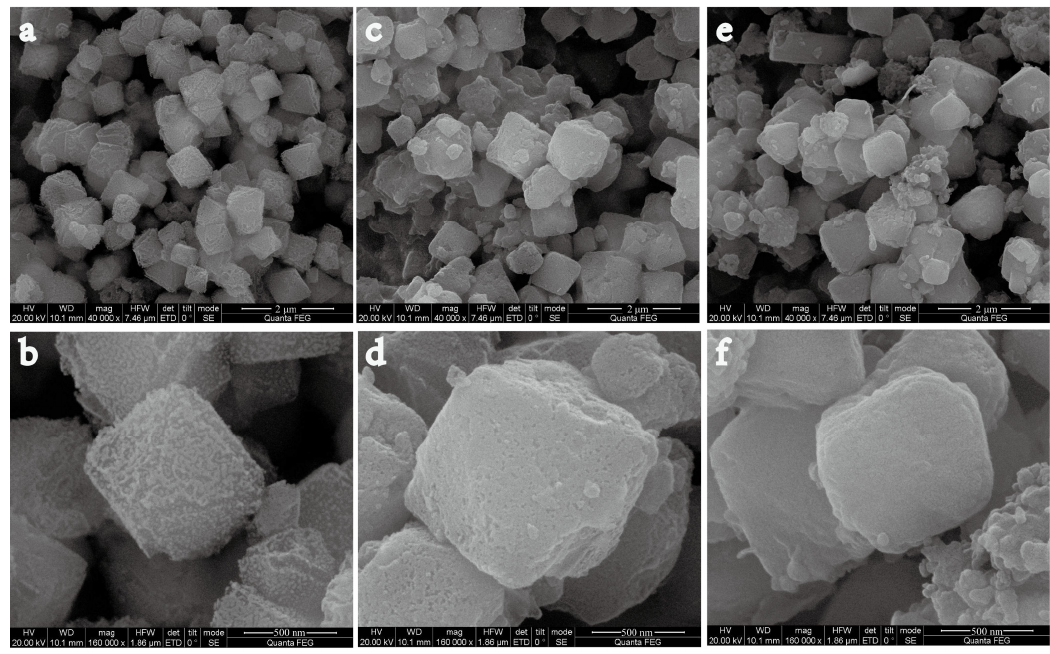
Figure 1. SEM images of the NH 2 -Fe-MIL-101 ( a , b ), Dini@NH 2 -Fe-MIL-101 ( c , d ) and PDA@Dini@NH 2 - Fe-MIL-101. Scale length: ( a , c , e ) 2 μm; ( b , d , f ) 500 nm.